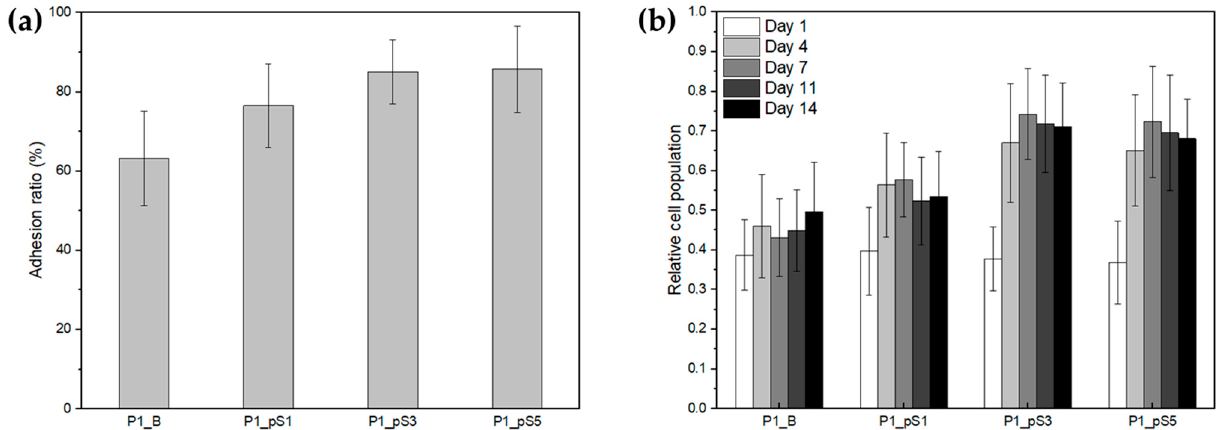
Figure 8. ( a ) Comparison of the human osteosarcoma Saos-2 cells adhesion ratios to the four pro- duced scaffolds: without pSPIONs (P1_B), containing 1.92 wt.% of pSPIONs (P1_pS1), containing 3.77 wt.% of pSPIONs (P1_pS3), and containing 5.54 wt.% of pSPIONs (P1_pS5); ( b ) Comparison of cellular proliferation of human osteosarcoma Saos-2 cells cultured for 14 days on three different CS/PVA/HA/pSPIONs scaffolds and on CS/PVA/HA scaffolds as control. Absorbance values are normalized to the average absorbance of the control wells on day 1. The vertical lines represent the experimental standard deviation of the mean. Table 5. Adhesion ratio of Saos-2 cells to the scaffolds: P1_B, P1_pS1, P1_pS3, and P1_pS5; and results of the statistical significance tests regarding the differences between the adhesion ratios. Adhesion ratio was calculated using day 1 cell population data. Uncertainty is the experimental standard deviation of the mean.